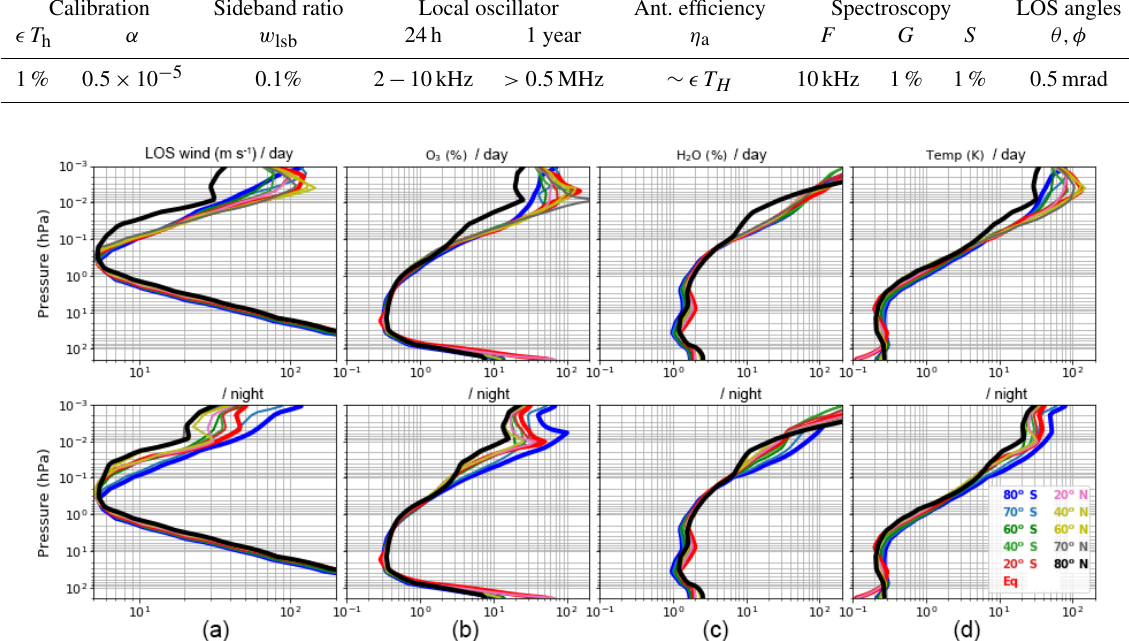
Figure 7. Single-scan retrieval precision (1 σ ) for line-of-sight wind (a) , O 3 (b) , H 2 O (c) and temperature (d) . The line colors correspond to latitude bins (see legend) and thick lines are used for those corresponding to polar and equatorial regions. Errors are given for day- and night-labeled profiles. Note that southern (northern) polar profiles are actually both daytime (nighttime)